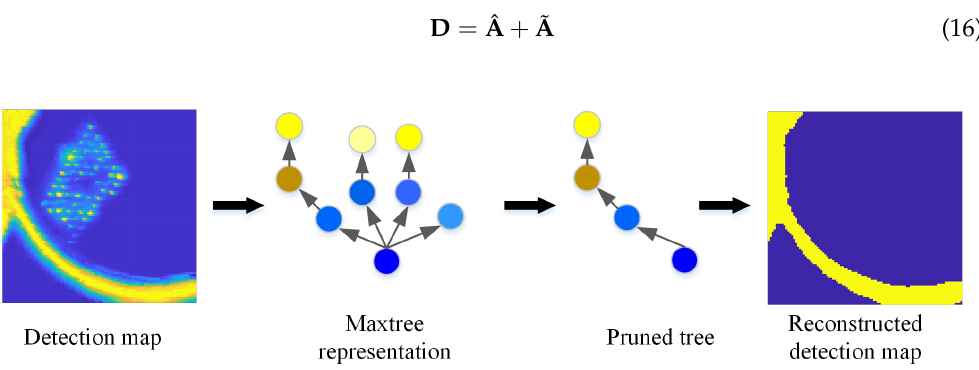
Figure 2. Schematic of the Maxtree representation and filtering